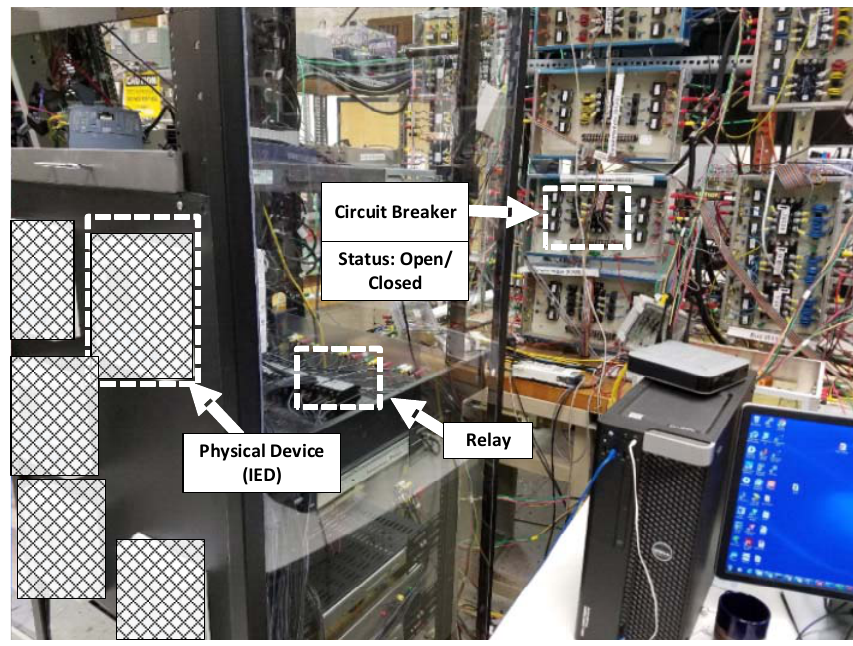
Figure 4. Experimental Setup with Commercial Intelligent Electronic Devices (IEDs).